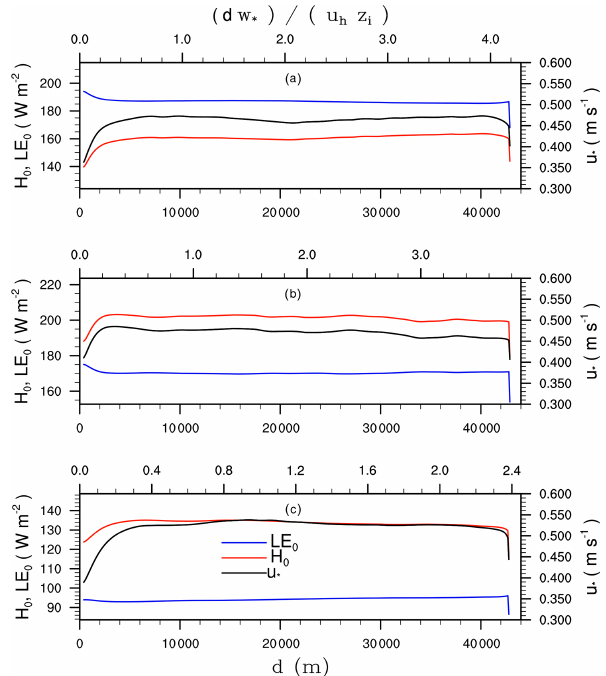
Figure 16. Horizontal profiles of 30min surface latent LE 0 and sen- sible H 0 heat flux as well as friction velocity u ∗ depending on the distance to the inflow boundary at (a) 10:00UTC, (b) 13:00UTC, and (c) 16:00UTC. The lower abscissa indicates the absolute dis- tance to the inflow boundary, while the upper abscissa indicates the travel time of an imposed signal normalized with the eddy-turnover time. H 0 and LE 0 are plotted with respect to the left ordinate, while u ∗ is plotted with respect to the right ordinate. The shown values are averaged over similar distances to the inflow